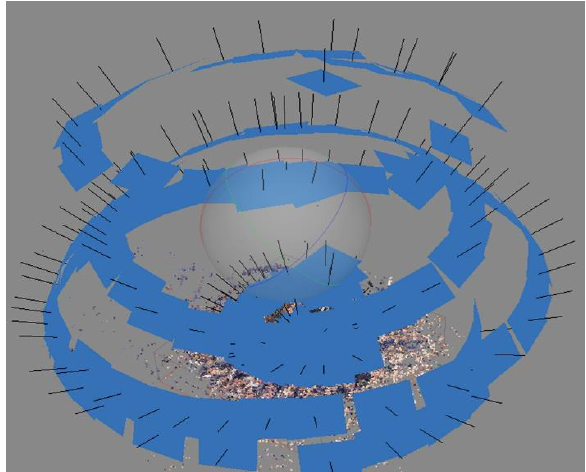
Figure 5. Data set for GE model: chunk 1